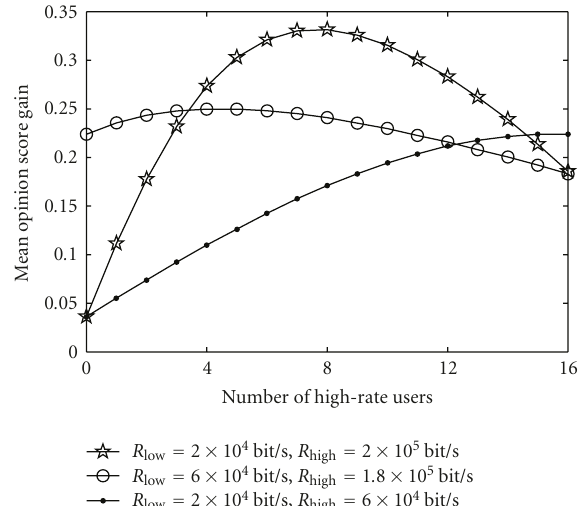
Figure 13: Impact of rate-distortion characteristic on the average MOS. Solid and dashed lines show results for the proposed CLO and equal resource allocation, respectively.